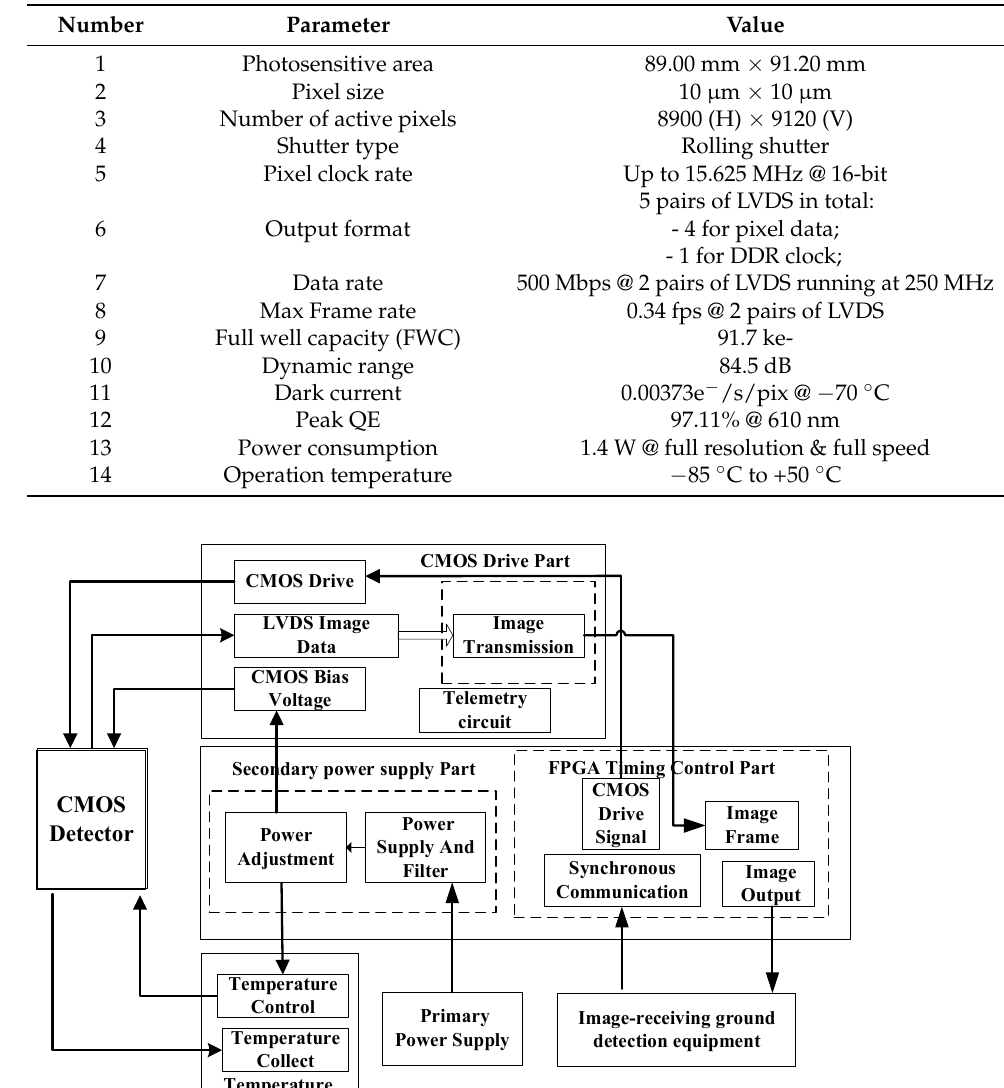
Table 2. Technical specifications of the CMOS detector.